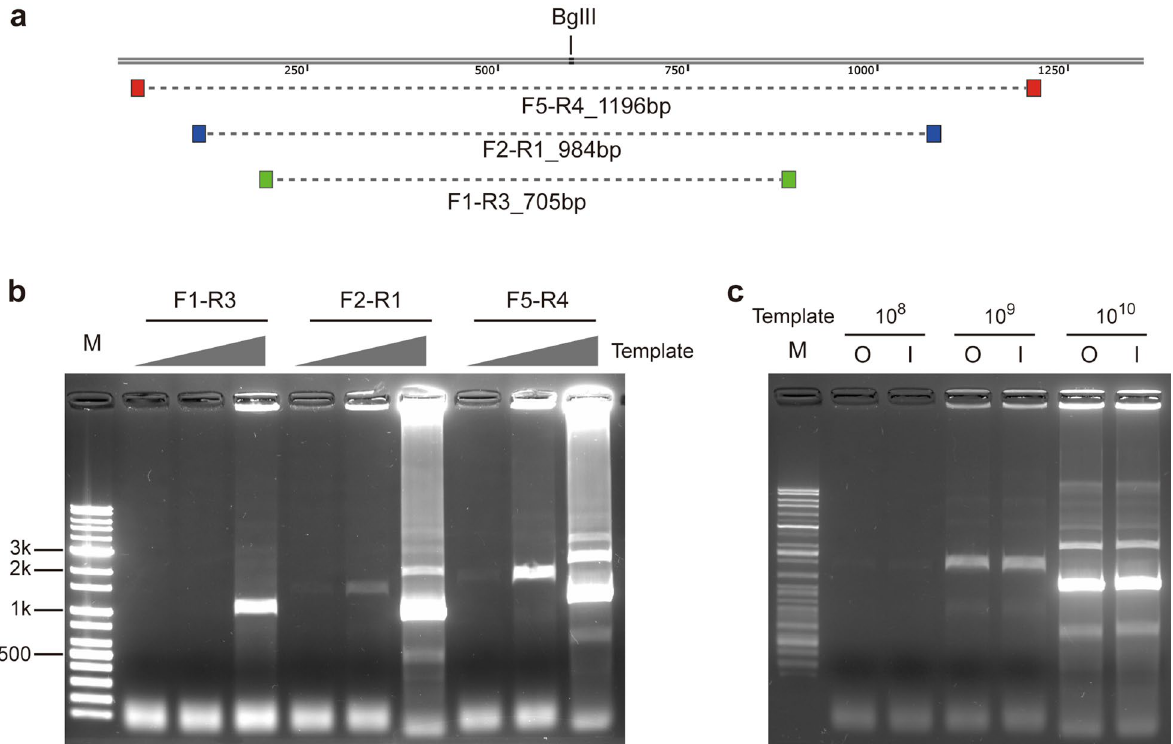
Figure 2. CREA targeting hCoV-OC43 nucleocapsid . ( a ) Position of loxP-primers and target length of each primer sets are designated. Position of selected restriction enzyme (BglII) is also marked. ( b ) CREA reaction by primer sets using different template copies of 4.3 × 10 8 , 4.3 × 10 9 and 4.3 × 10 10 . The same binding region of loxP- primers are chosen for RCA. Sizes of some marker bands are indicated. ( c ) CREA on F5-R4 target with different RCA primer sets by template copies. “O” stands for outer primer set which used F5-R4 RCA primers. “I” stands for inner primer set which used F1-R3 RCA primers. Template copy number set is the same as ( b ). M; marker. Because of non-uniform incorporation of SYBR green I added to the sample before gel loading, disturbance or inaccurate migration